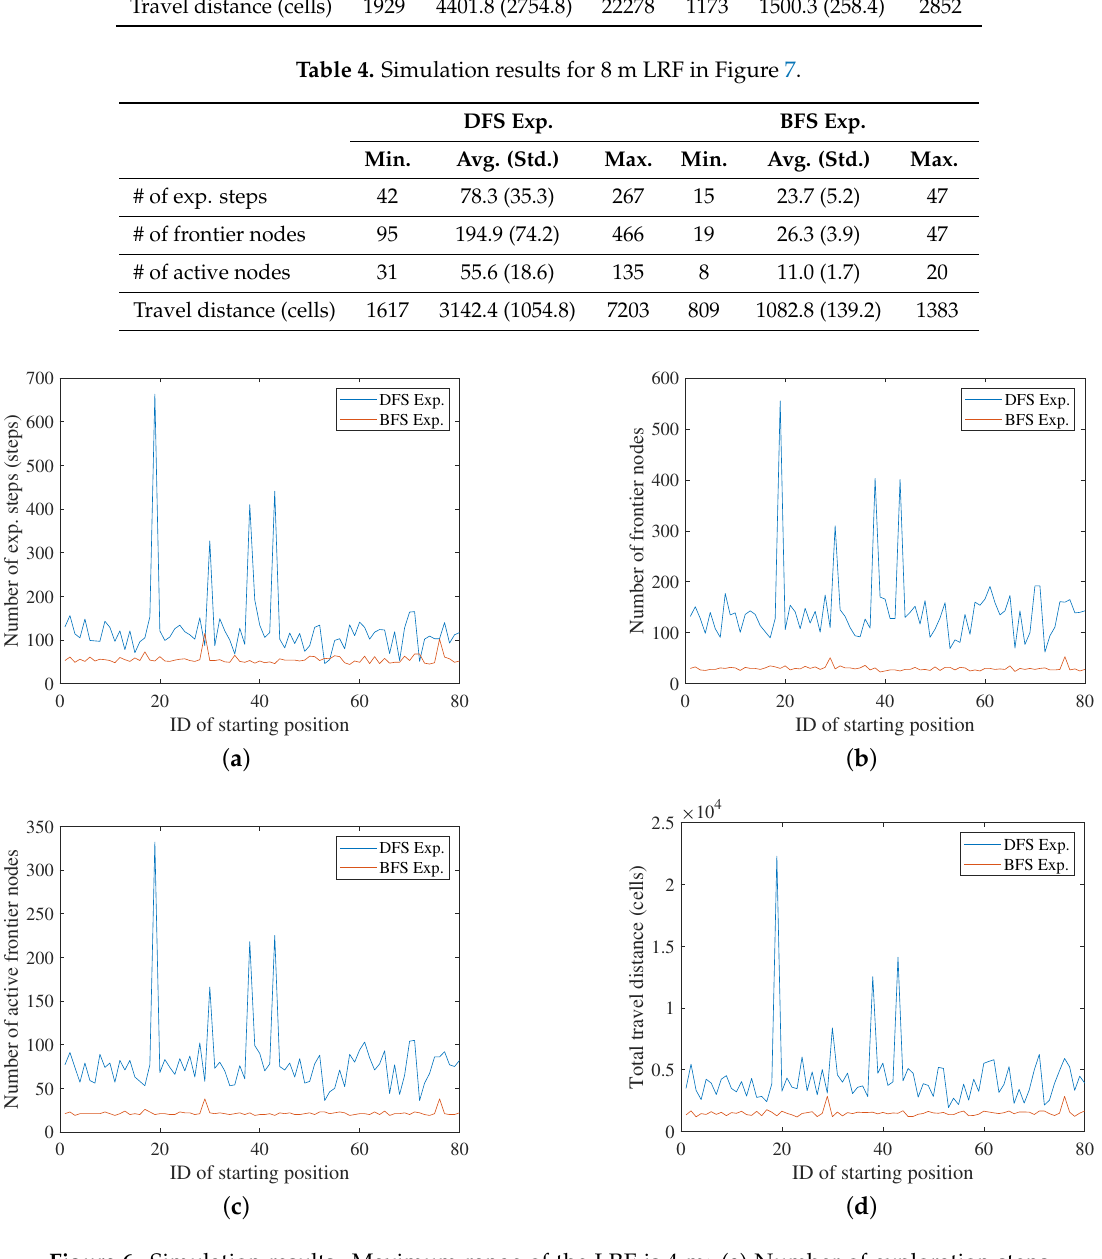
Figure 6. Simulation results. Maximum range of the LRF is 4 m: ( a ) Number of exploration steps until the exploration is completed. ( b ) Total number of registered frontier nodes in the frontier-graph. ( c ) Number of active nodes. ( d ) Total traveling